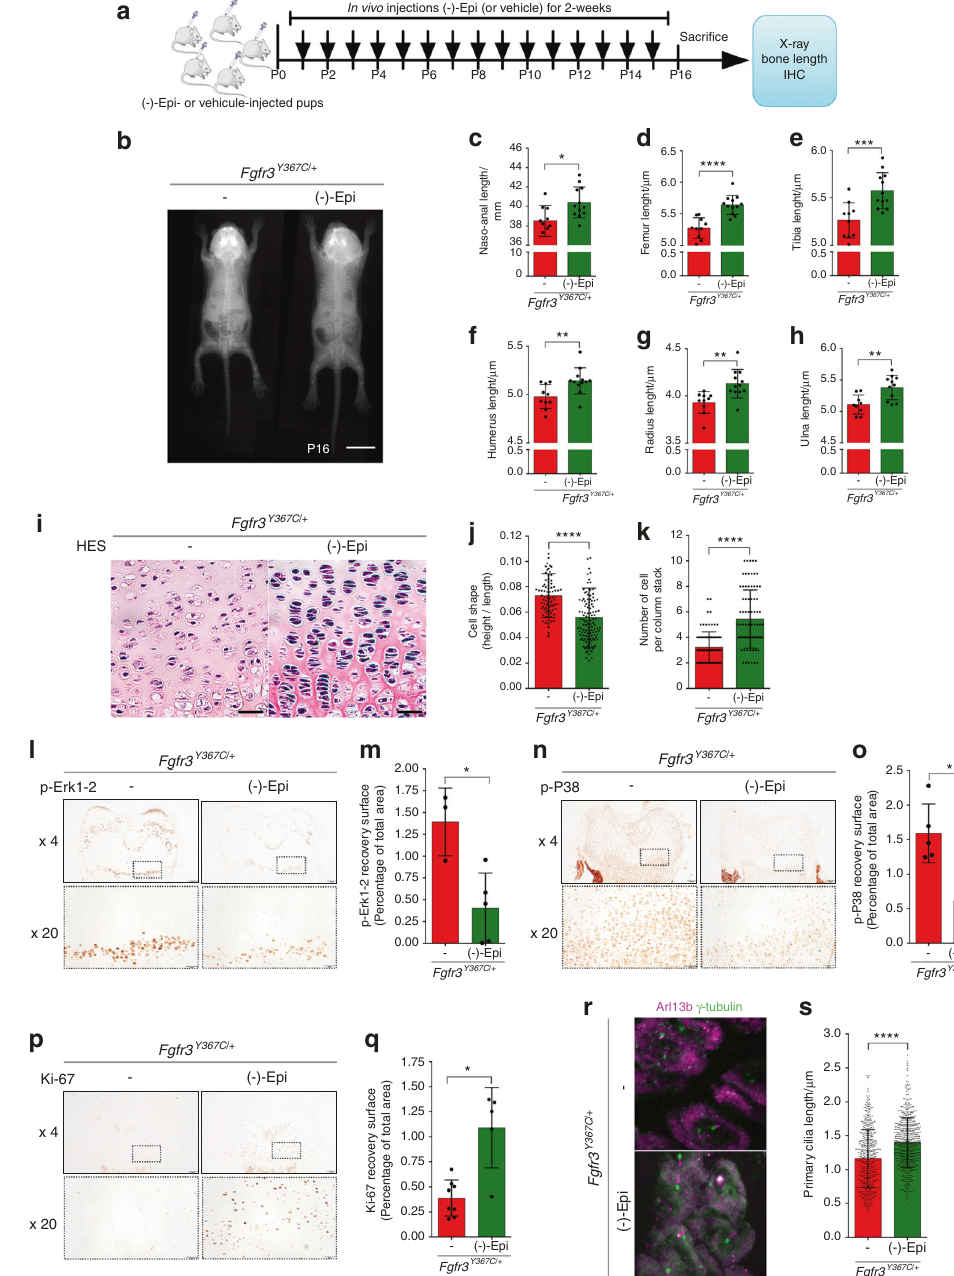
Fig. 5 In vivo-injected (-)-epicatechin increases bone growth, modi fi es chondrocyte proliferation, and differentiation and promotes primary cilium elongation. a Sequential representation of the in vivo protocol. b Radiographs of Fgfr3 Y367C/ + mice treated with vehicle or (-)-epicatechin for 16 days and graphical representations of the naso-anal lengths ( c ), femur lengths ( d ), tibia lengths ( e ), humerus lengths ( f ), radius lengths ( g ), and ulna lengths ( h ). i Representative HES staining images of the distal femurs. Scale bars: 50 μ m. j Graphical representation of the cell height/cell length ratio in the growth plate proliferative zone in Fgfr3 + / + ( n = 80) and Fgfr3 Y367C/ + mice treated ( n = 80) or not ( n = 120) with (-)-epicatechin for 16 days. k Number of cells per column stack in the growth plate proliferative zone in Fgfr3 Y367C/ + mice treated ( n = 6) or not ( n = 6) with (-)-epicatechin for 16 days. l Representative image of p- ERK1/2 in Fgfr3 Y367C/ + distal femurs in the presence ( n = 5) or absence ( n = 5) of (-)-epicatechin. Scale bars: 200 μ m. m Graphical representation of the surface of the p-ERK1/2-positive zone in Fgfr3 Y367C/ + distal femurs in the presence ( n = 5) or absence ( n = 5) of (-)-epicatechin. n Representative image of p-p38 in Fgfr3 Y367C/ + distal femurs in the presence ( n = 5) or absence ( n = 5) of (-)-epicatechin. Scale bars: 200 μ m. o Graphical representation of the surface of the p-p38-positive zone. p Representative image of Ki-67 in Fgfr3 Y367C/ + distal femurs in the presence ( n = 5) or absence ( n = 5) of (-)-epicatechin. Scale bars: 200 μ m. q Graphical representation of the surface of the Ki-67-positive zone in Fgfr3 Y367C/ + distal femurs treated or not with (-)-epicatechin. r Representative confocal microscopy images of primary chondrocytes from in vivo Fgfr3 Y367C/ + femoral growth plates exposed or not to (-)-epicatechin. s Graphical representation of the length of the primary cilium in chondrocytes after in vivo treatment (see also Supplementary Fig. 8 for enlarged images). PZ proliferative zone (purple arrow), HZ hypertrophic zone (blue arrow). Data are presented as the mean ± SD. ns not signi fi cant; *P < 0.05; **P < 0.01; ***P < 0.001; ****P < 0.000 1 by two-tailed, unpaired t